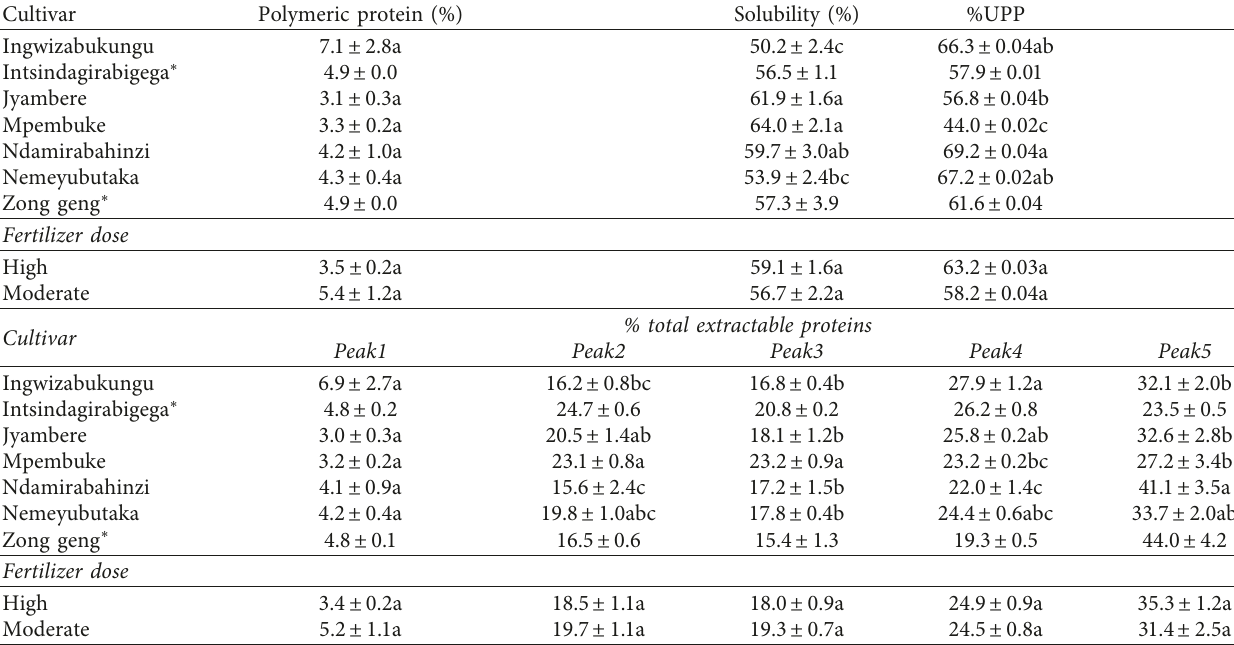
Table 5: Amount and size distribution of polymeric and monomeric protein in Rwandan rice cultivars.